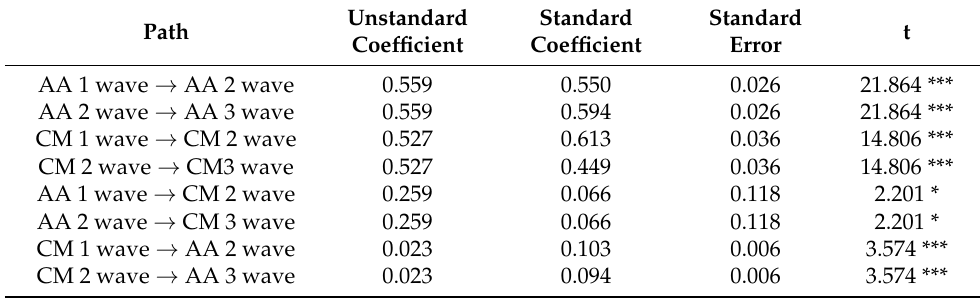
Table 4. Path coefficients of cross-lagged model. Path